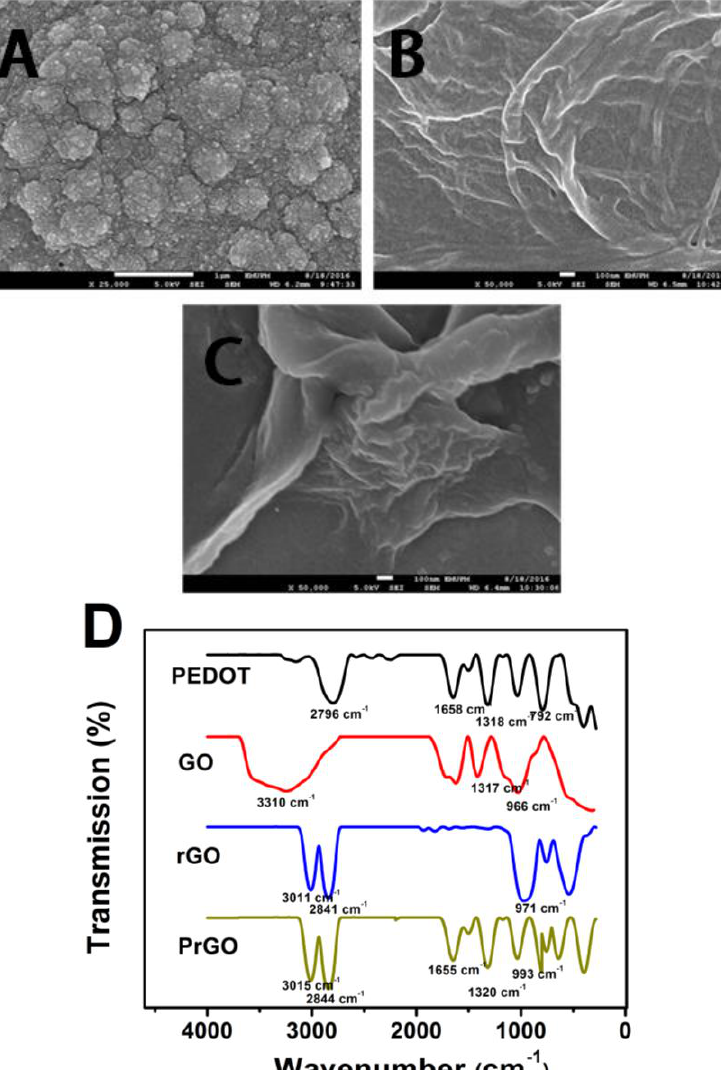
Figure 2. SEM images of ( A ) PEDOT, ( B ) rGO and ( C ) PrGO composite, ( D ) FTIR spectra of PEDOT, GO, rGO and PrGO composite.